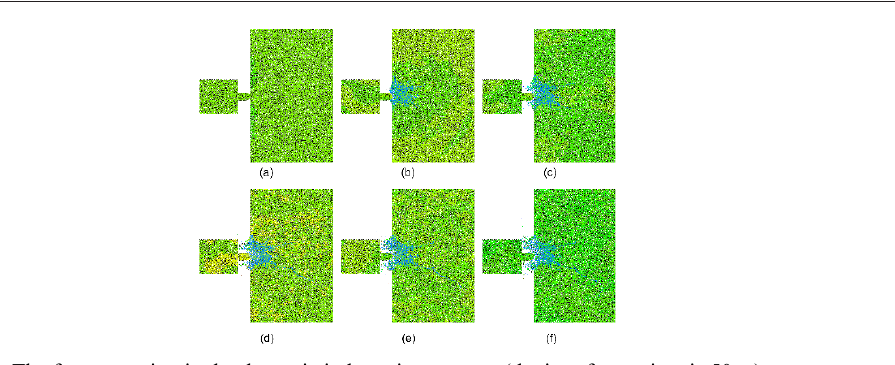
Fig. 4. The fragmentation in the dynamic indentation process (the interframe time is 50µs).